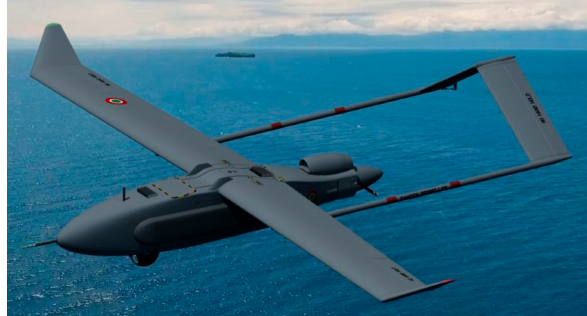
Figure 1. Rendering of the TERSA UAV